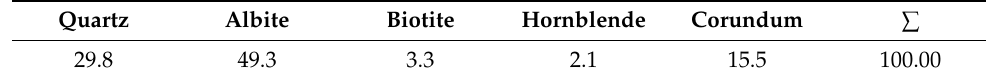
Table 5. Mineral composition of GMM (wt.%).